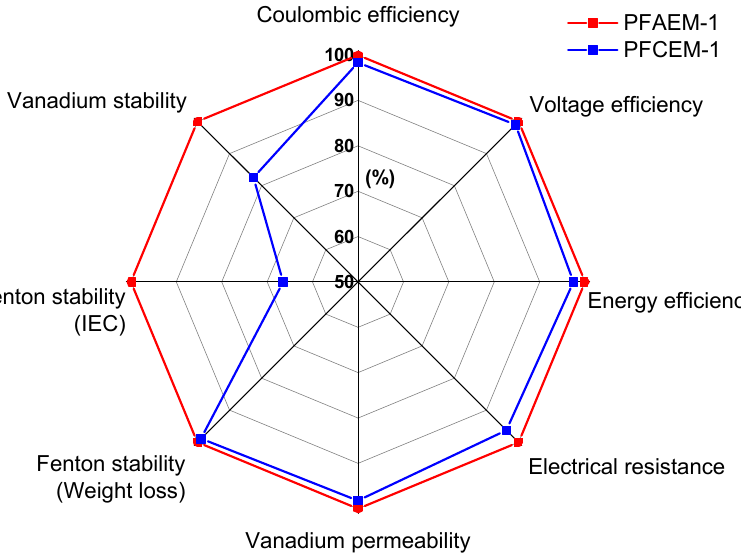
Figure 12. Spider chart for comparing the performances of the PFAEM and PFCEM in a VRFB system.